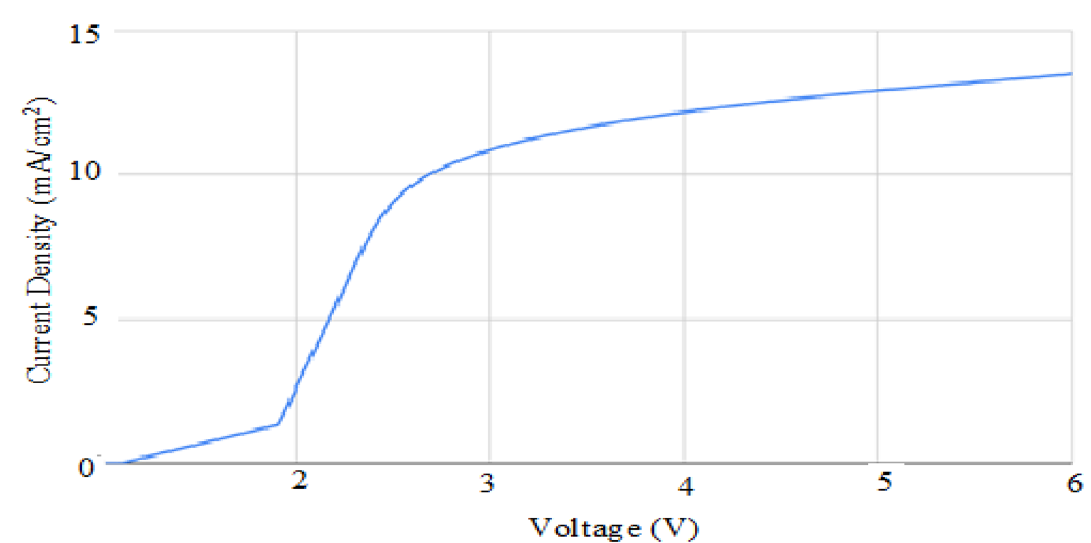
Figure 6. Current density vs voltage for the selected